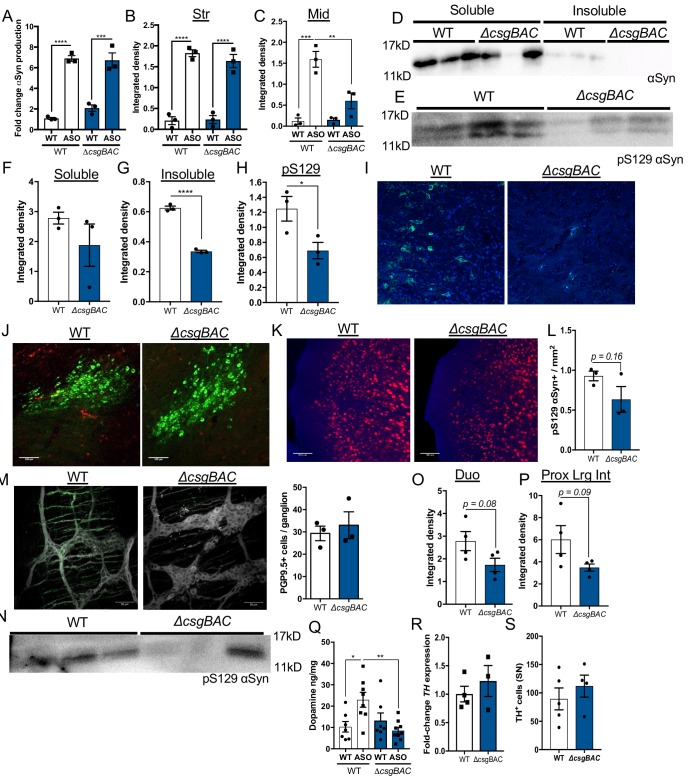
Mono-colonization with curli-sufficient bacteria induce increased αSyn-dependent pathology Germ-free (GF) wild-type (WT) or Thy1-αSyn (ASO) animals were mono-colonized with curli-sufficient E. coli (WT) or curli-deficient E. coli (ΔcsgBAC).(A) Total αSyn in whole brain lysates quantified by ELISA. Quantification of insoluble αSyn fibrils in the (B) striatum and (C) midbrain by dot blot assay. Midbrain homogenates of ASO animals were (D) fractionated with Triton X-100 and SDS-PAGE, and subsequently probed for alpha-synuclein (αSyn) via western blot, or (E) left unfractionated and assessed by western blot for phospho-Serine129 αSyn (pS129). (F–H) Quantification of western blots by integrated density. Representative images from of mono-colonized ASO mice of the (I) midbrain stained for proteinase K-resistant αSyn (green), (J) substantia nigra stained for tyrosine hydroxylase (TH, green) and pS129 (red), and (K) frontal cortex stained for pS129 (red) and quantified in (L). (M) Representative images of the myenteric plexus within proximal large intestine of mono-colonized ASO animals stained for PGP9.5 (white) and pS129αSyn (green,), and counts of PGP9.5+ cells bodies per ganglia. (N) Proximal large intestine homogenates of mono-colonized ASO animals were assessed by SDS-PAGE and analyzed by western blot for pS129αSyn. Quantification of insoluble αSyn fibrils in the (O) duodenum and (P) proximal large intestine by dot blot assay. (Q) Total striatal dopamine quantified by ELISA. (R) TH expression in the midbrain by qPCR. (S) Quantification of TH+ cells in representative sections of the SN. n = 3 (A–H, L), n = 4 (O, P), n = 7–9 (Q), n = 3–4 (R), n = 4–5 (S). Full-length immunoblots available in associated Source Data file. Points represent individuals, bars represent the mean and standard error. Data analyzed by one-way ANOVA with Tukey post-hoc test for A-C, Q, or two-tailed t-test for F-H, L, O, P, R, S. *p≤0.05; **p≤0.01; ***p≤0.001; ****p≤0.0001. Scale bars = 100 μm.Figure 1—figure supplement 2—source data 1.Source data and statistical analysis.